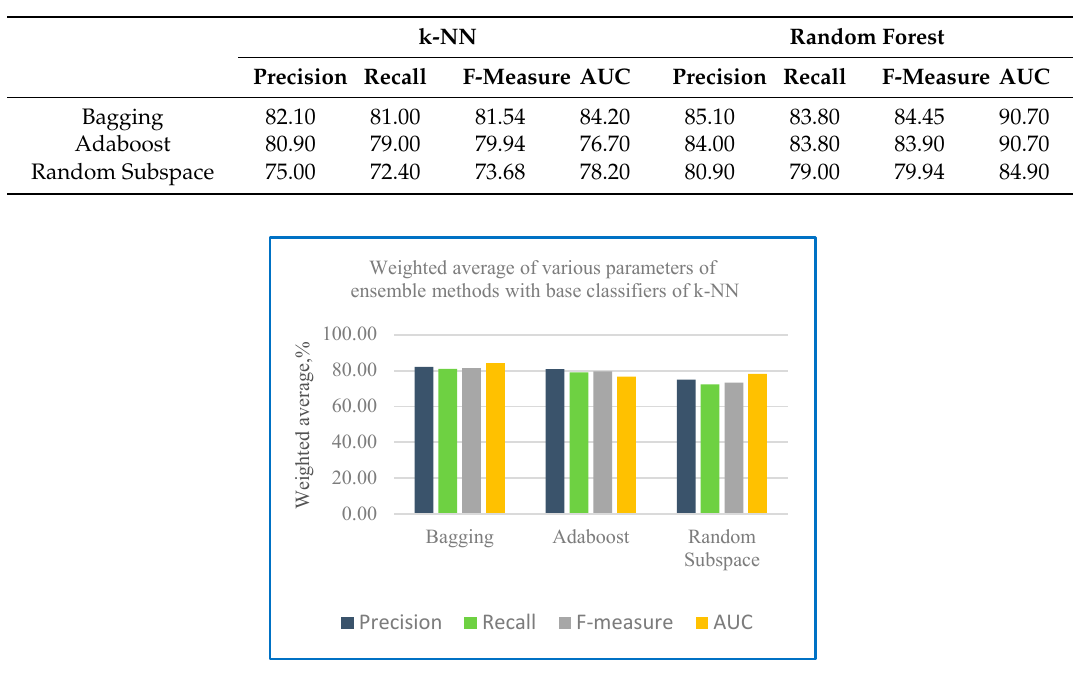
Figure 15. Weighted average of various parameters of ensemble methods with base classifiers of k-NN.